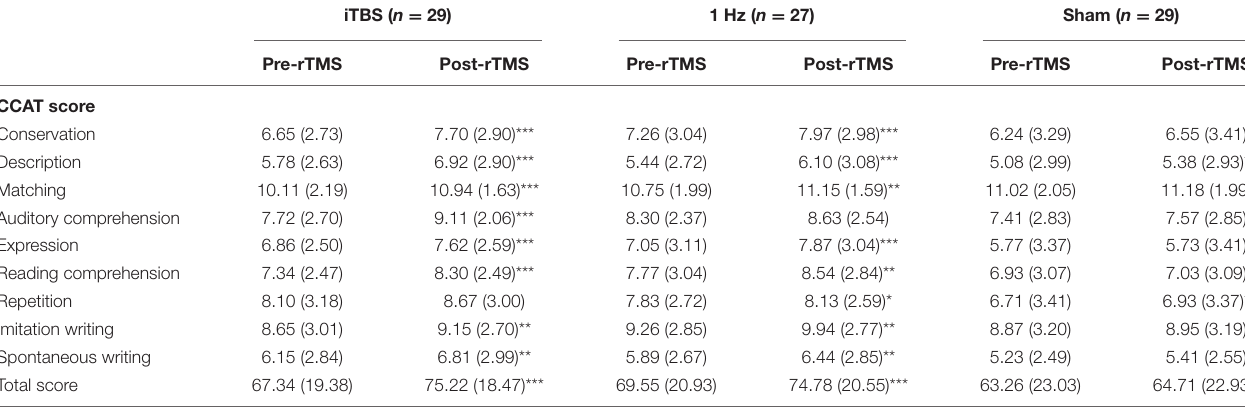
TABLE 2 | Mean Group Data (SD) of CCAT scores obtained pre- and post-rTMS